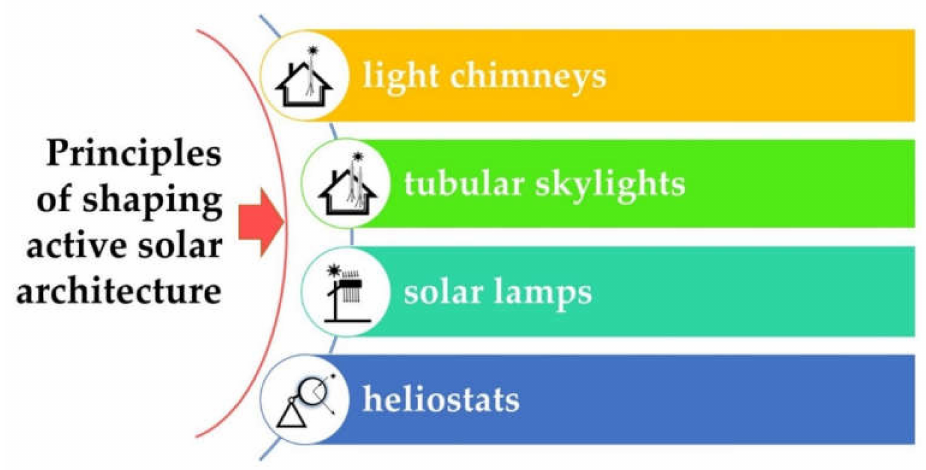
Figure 1. Principles for active solar architecture (authors, based on Baker and Steemes, 2000).